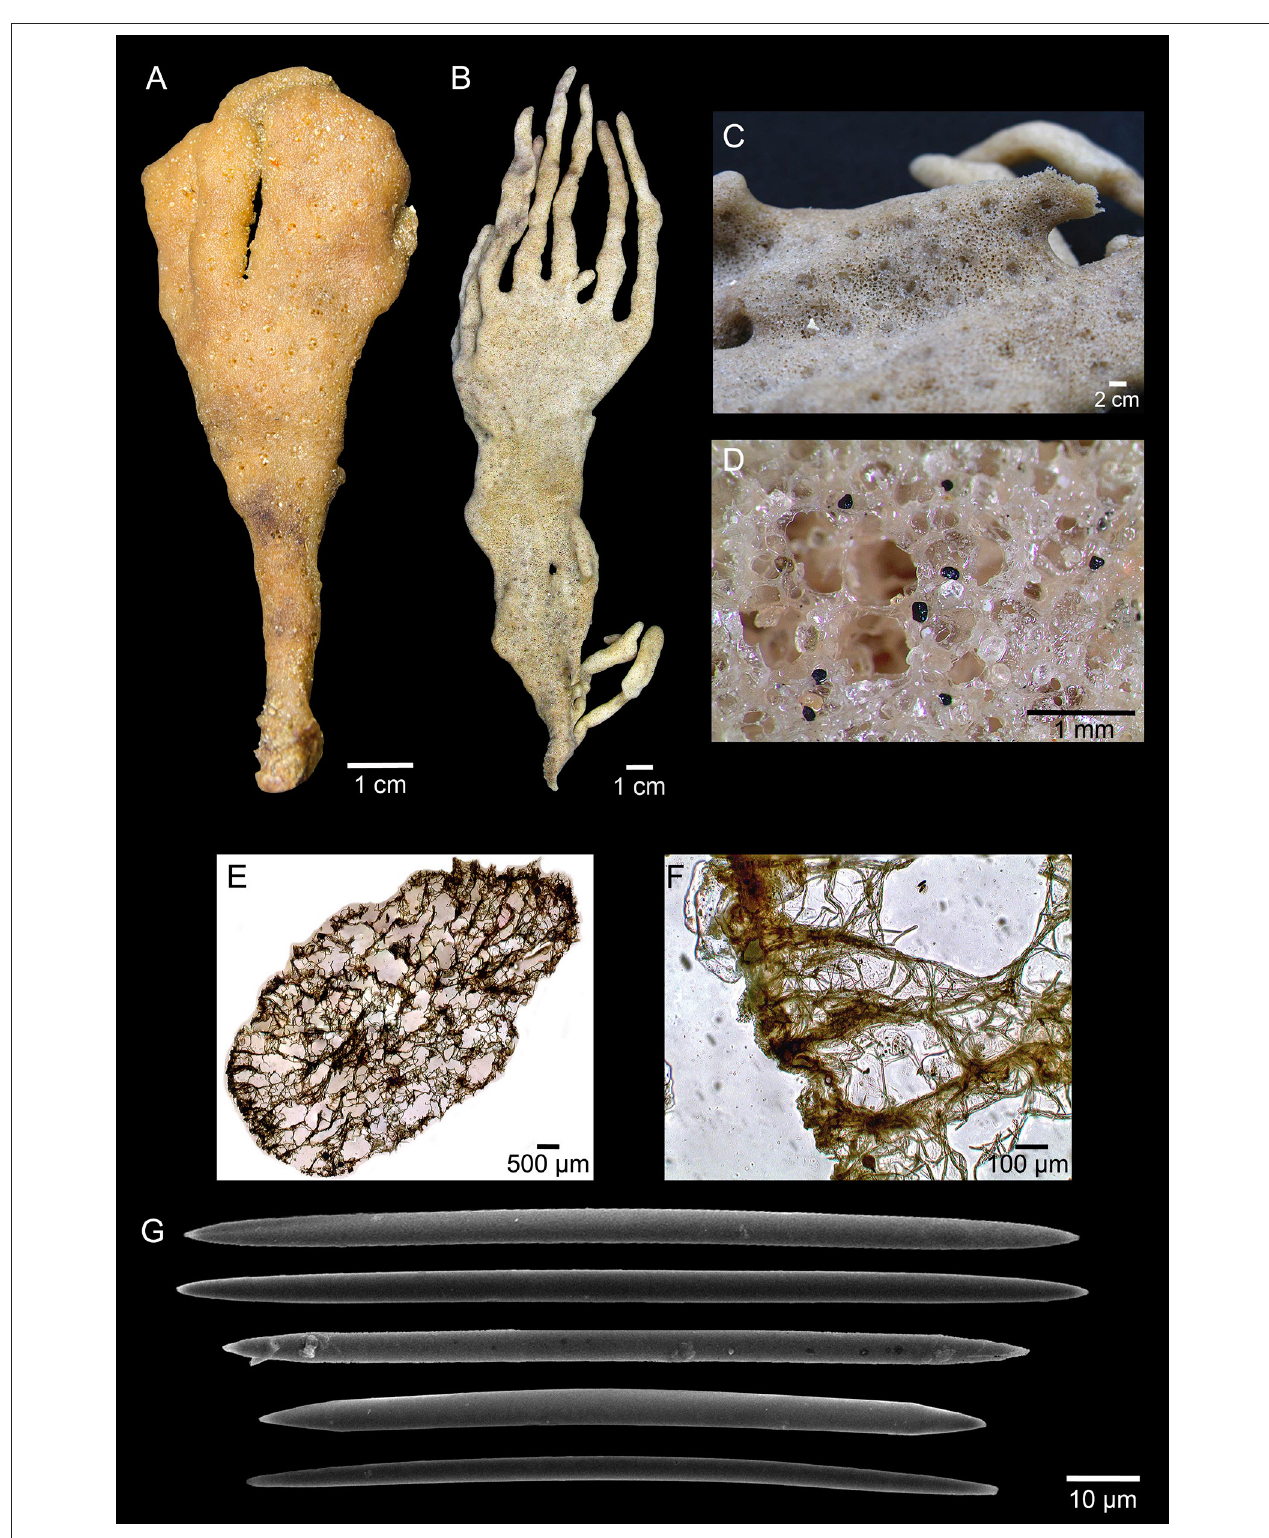
FIGURE 3 | Arenosclera amazonensis sp. nov. (holotype, A , MNRJ 18778; paratype, B–F , MNRJ 18798) morphological and anatomical traits. (A–B) Fixed specimens. (C) Sponge surface with several oscules. (D) Detail of surface and oscule rim showing rounded siliceous sand grains incorporated to spongin fibers. (E) ectosome and choanosome in transverse section showing reticulated spongin fibers. (F) Detail of ectosome and choanosome in transverse section showing spicule tracts inside spongin fibers. (G) Oxeas (both specimens).